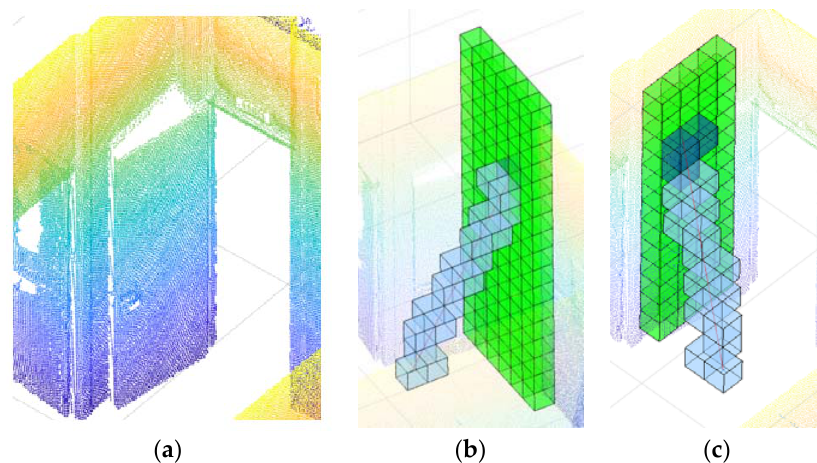
Figure 10. Door recognition: ( a ) point cloud of an open door; ( b ) positive (the beam only crosses empty voxels); ( c ) false positive, where the open door causes an occlusion on the wall shaped like a door (the beam crosses three occupied voxels). Green: recognized door; dark blue: occupied voxel; light blue: empty voxel.